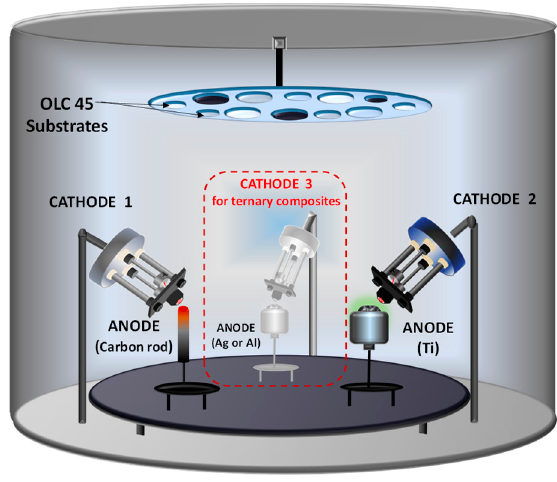
Figure 1. The schematic view of the experimental set-up. Table 1. The parameters for ternary and binary thin film synthesis.